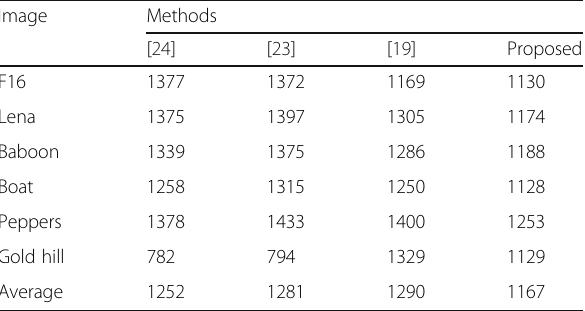
Table 5 File size increase (bytes) with payload size of 8000 bits Image